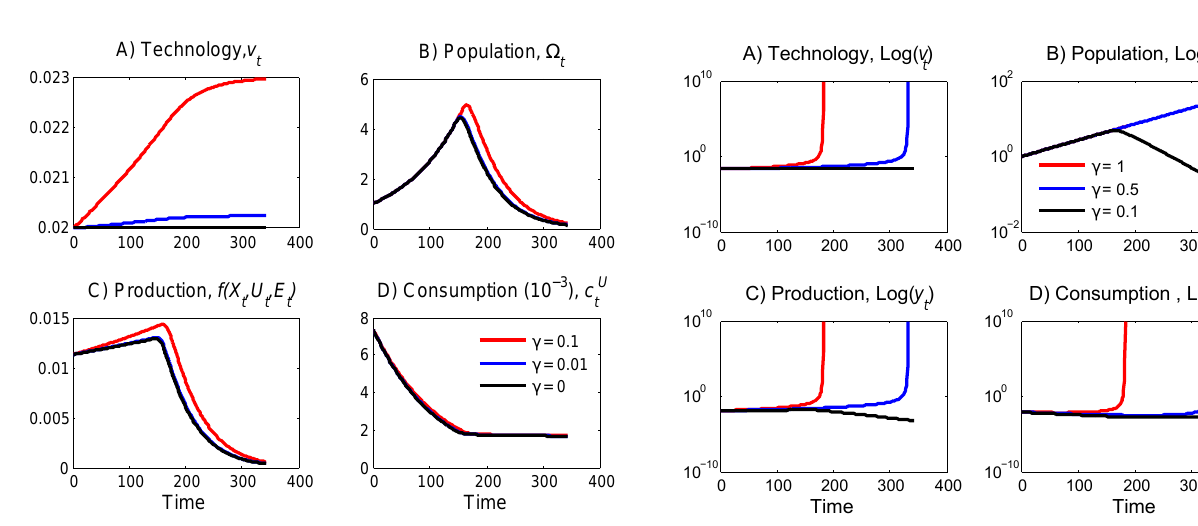
Figure 6. Technological singularity: the co-evolution of technology, population, production and consumption per capita under high rates of success ( γ = 0.50, 1.00) and modest rates of success ( γ = 0.10). The population growth rate threshold η = 0.25. No randomness in technological rate of success is assumed, i.e., γ = γ